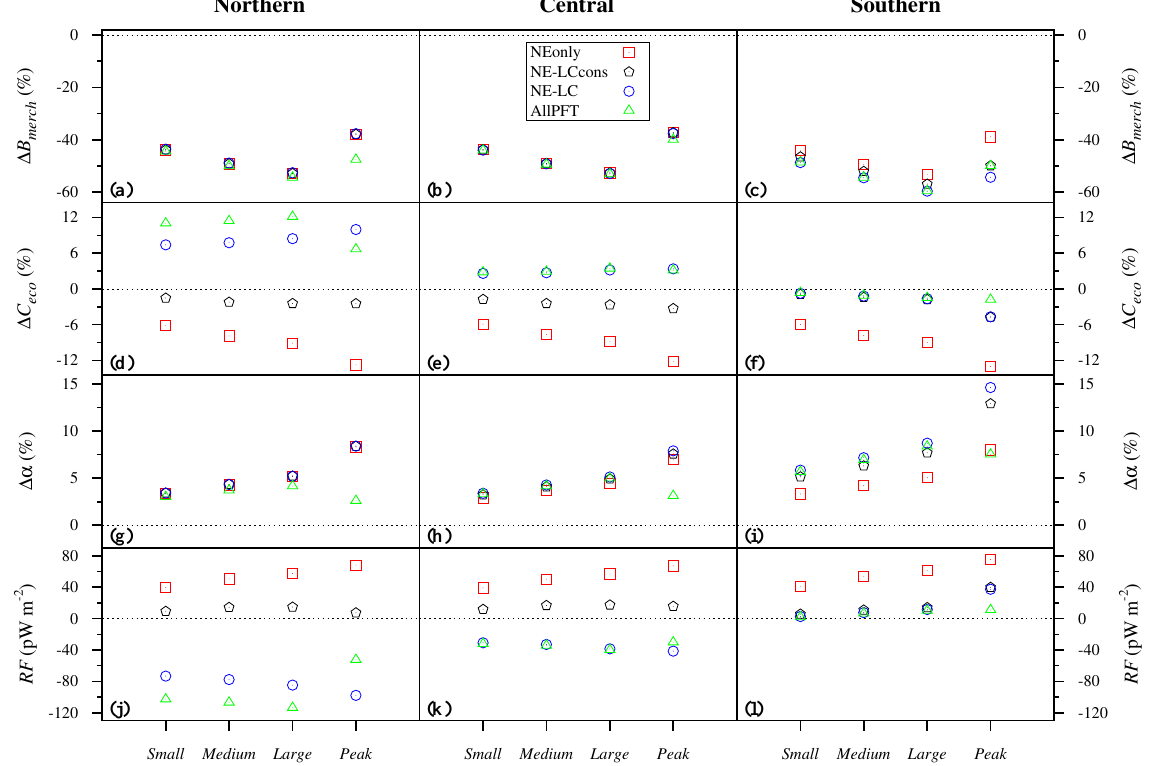
Figure 6. Mean effect over 240 years of the different MPB outbreak regimes on lodgepole pine merchantable biomass ( B merch ), ecosystem carbon ( C eco ), surface albedo ( α ), and radiative forcing (RF; in pico-Wm − 2 , for 1ha outbreaks) compared with the no-outbreak control, for the three locations (Fig. 1) and four vegetation coexistence scenarios (Table 2). Control values differed among locations and vegetation coexistence scenarios, so the same relative change (in %; panels a through i ) does not correspond to the same absolute